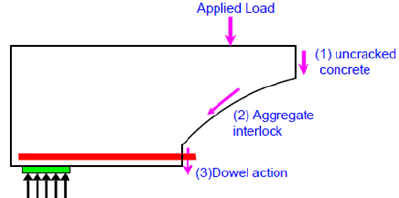
Figure 7: Mechanism of shear transfer in a cracked concrete beam